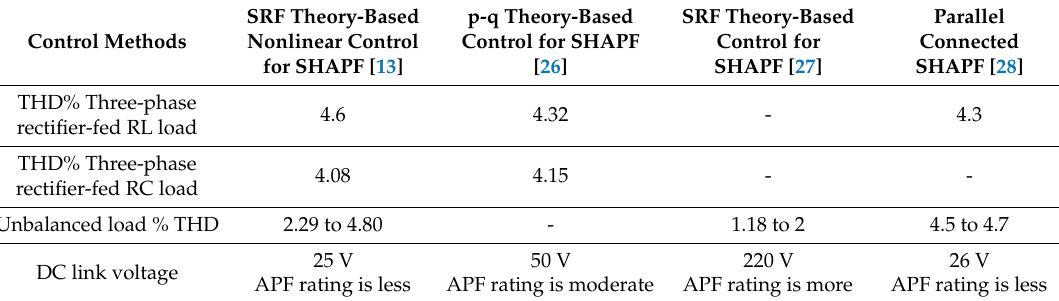
Table 3. Comparison of the performance of various control